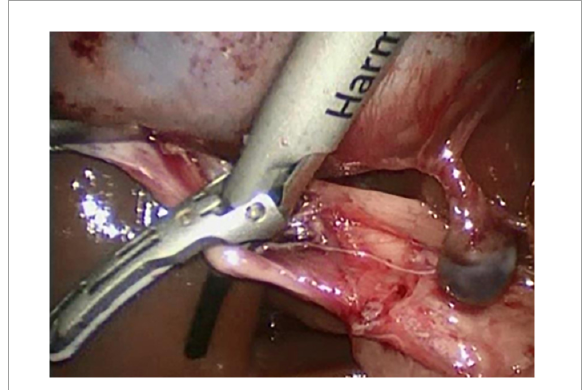
FIGURE1 Delivery of the harmonic shear around the cystic duct.